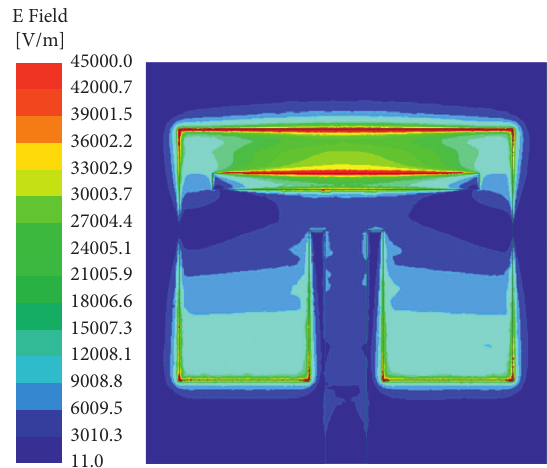
Figure 5: Electric field distribution of microstrip